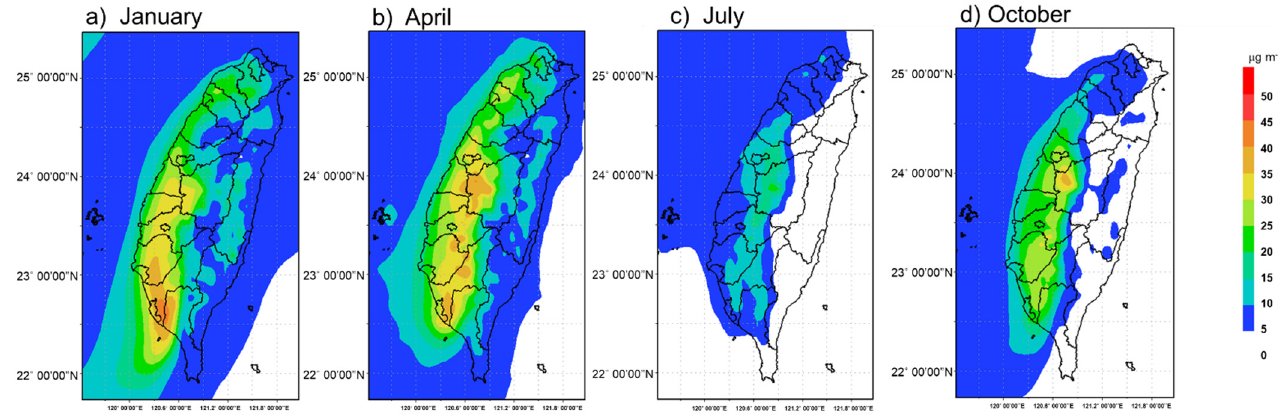
Figure 9. PM 2.5 concentration ( µ g m − 3 ) simulations for January ( a ), April ( b ), July ( c ), and October ( d ) under scenario